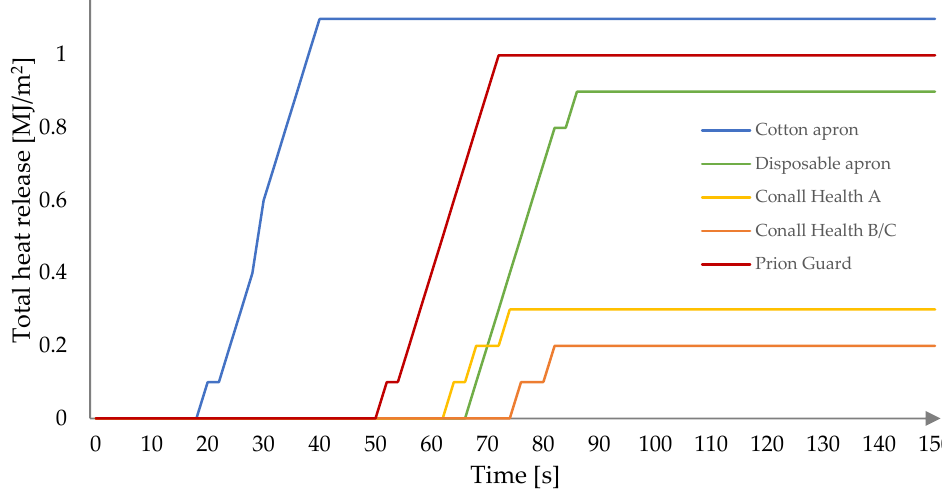
Figure 2. Total heat release of studied fabrics at heat flux of 25 kW/m 2 .